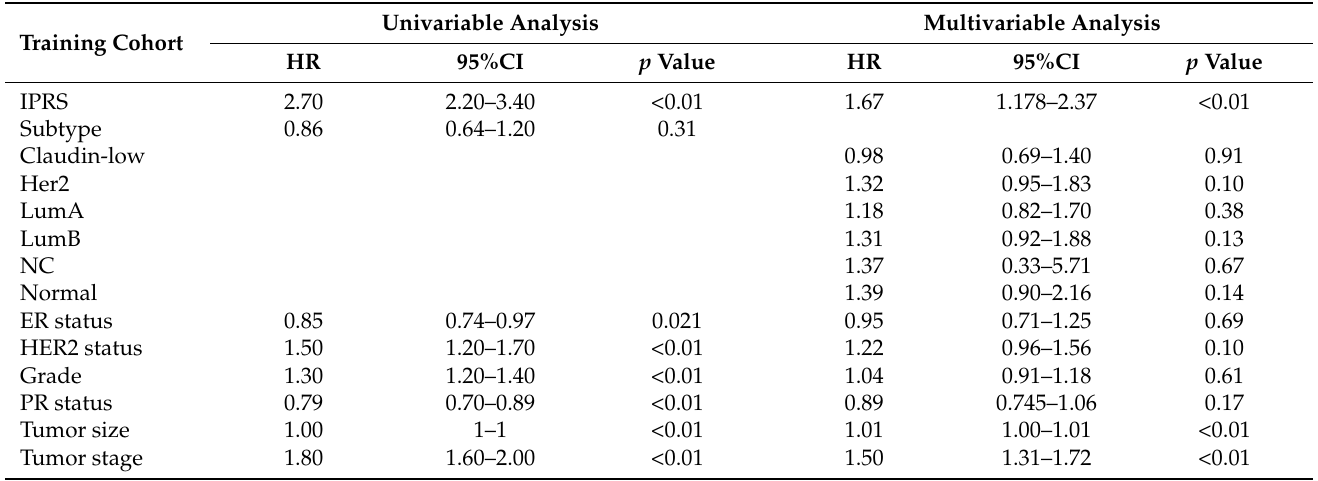
Table 2. Univariable and multivariable Cox analysis of IPRS and clinic-pathological factors (subtype, ER status, HER2 status, grade, PR status, tumor size, tumor stage) for OS in the Bernard cohort.